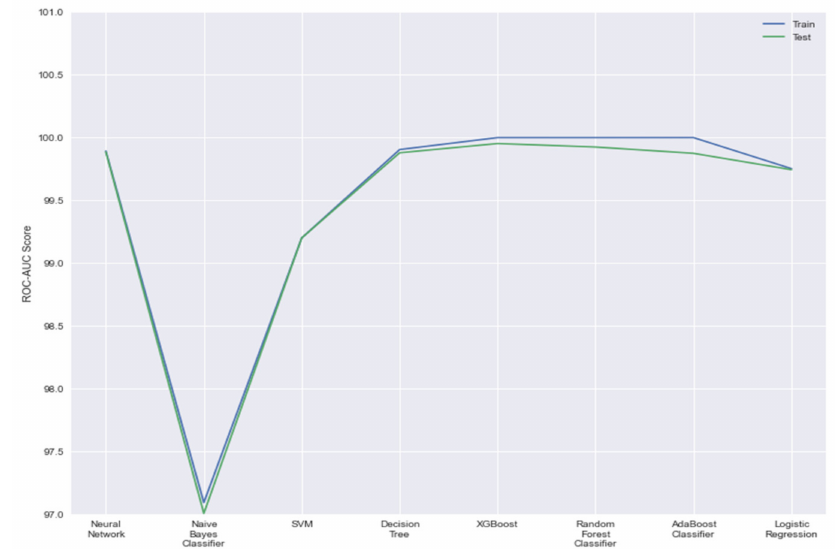
Figure 6. ROC-AUC scores of all